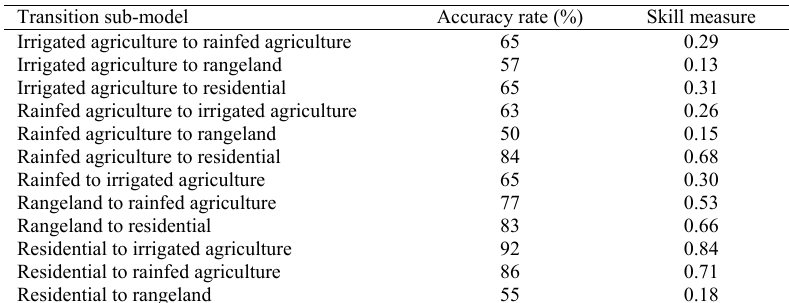
Table 1: Accuracy rate and skill measure for different transition sub-models in MLP approach